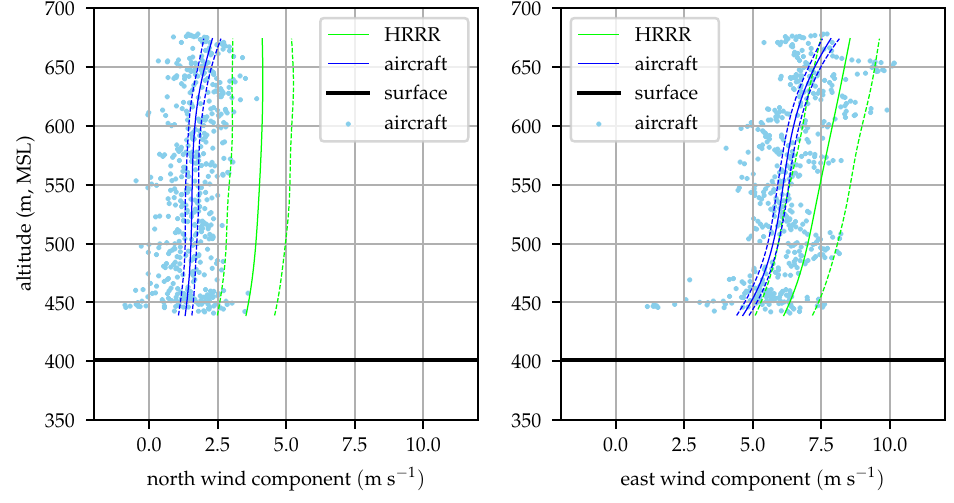
Figure 19. Aircraft measured and HRRR predicted wind profiles at 09:00 local time (2018-12-06).